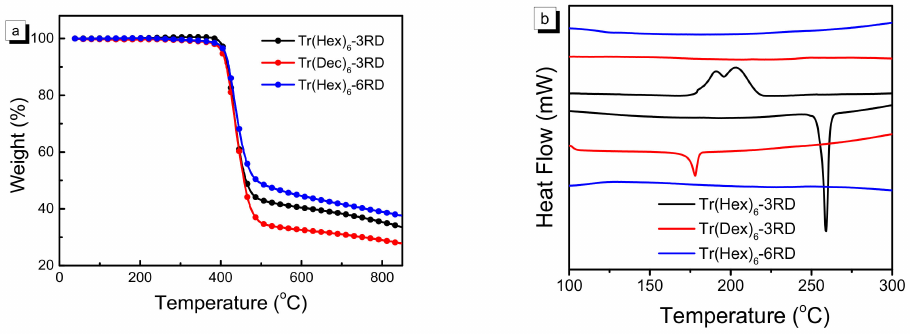
Figure 2. ( a ) TGA and ( b ) DSC spectra of truxene-centered